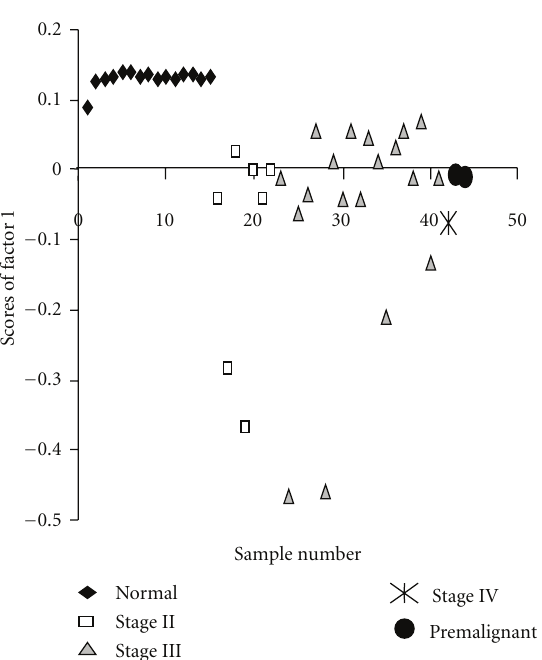
Figure 3: Plot of sample number versus scores of factor 1 for the combined set of samples.